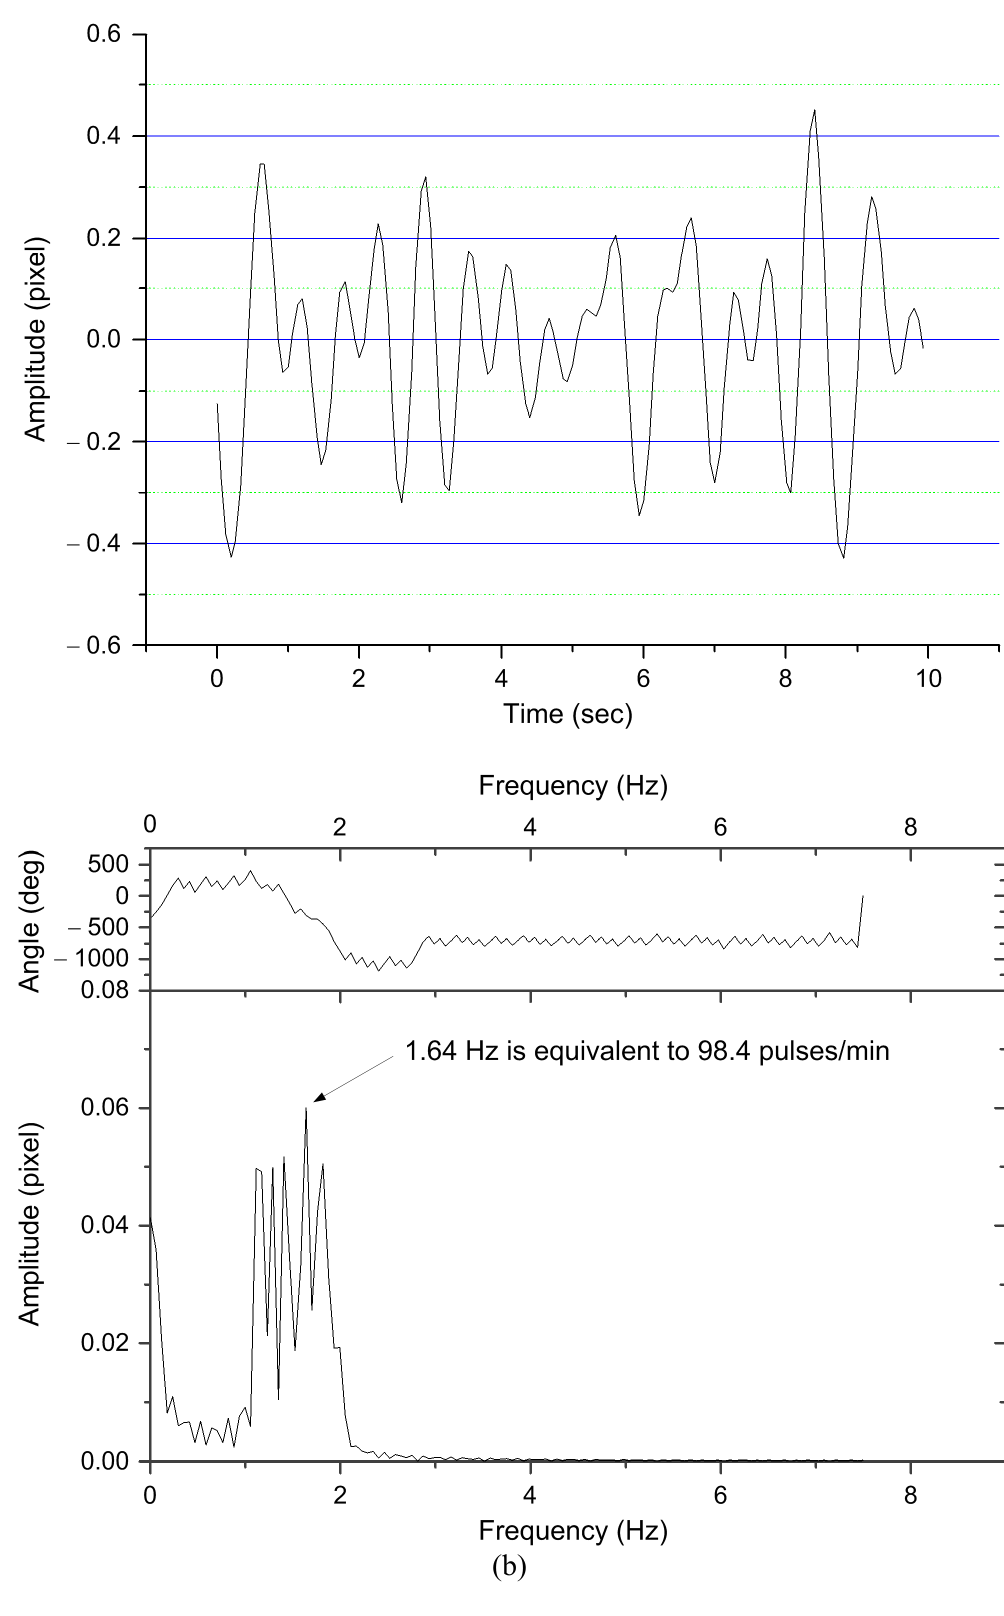
Figure 13. Pulse information for the Guan point on the left hand (liver) of the tested subject: (a) before staying up late ( to be continued